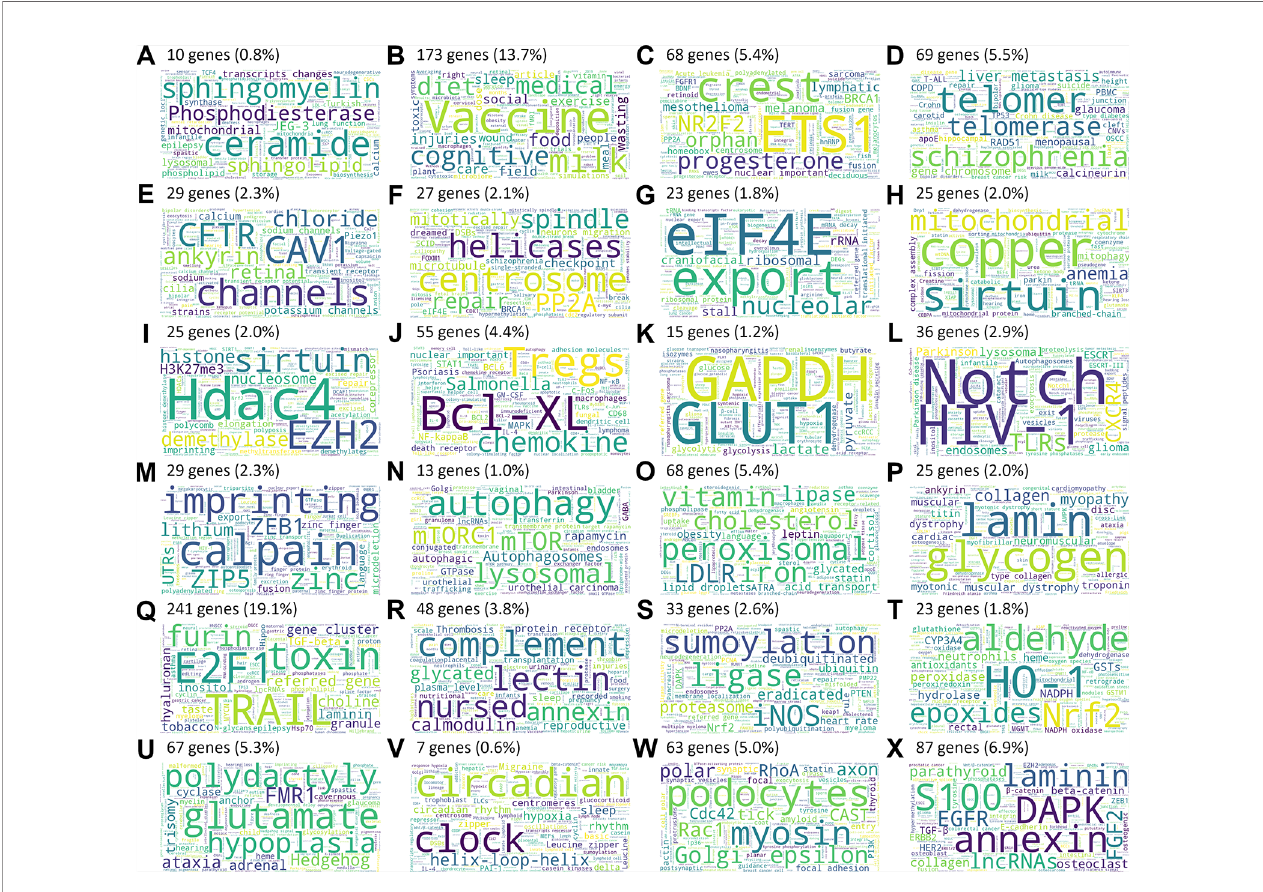
FIGURE 4 | Word clouds summarizing the most frequent and speci fi c terms among the 24 gene clusters (A – X) .